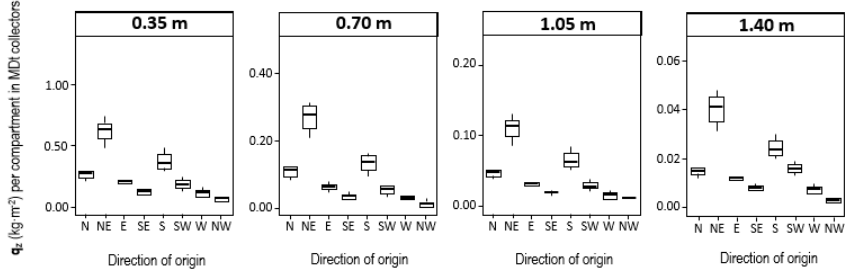
Figure 4. Sediment flux (q z ) per MDt collector compartment by trap height and direction of origin. Table 1. Characteristics of soils and sediments in MDt compartments.